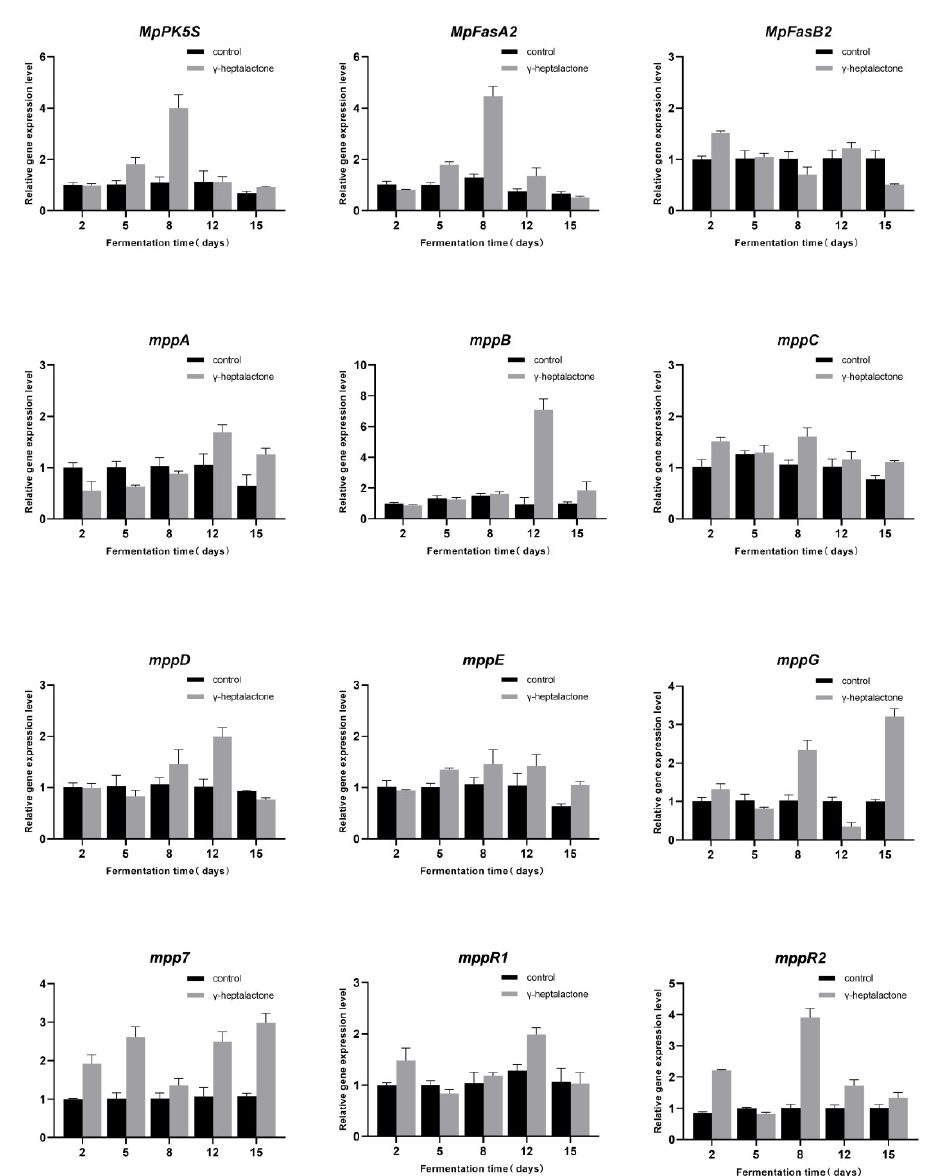
Figure 3. Effect of γ -heptalactone on the relative gene expression levels of MPs biosynthesis